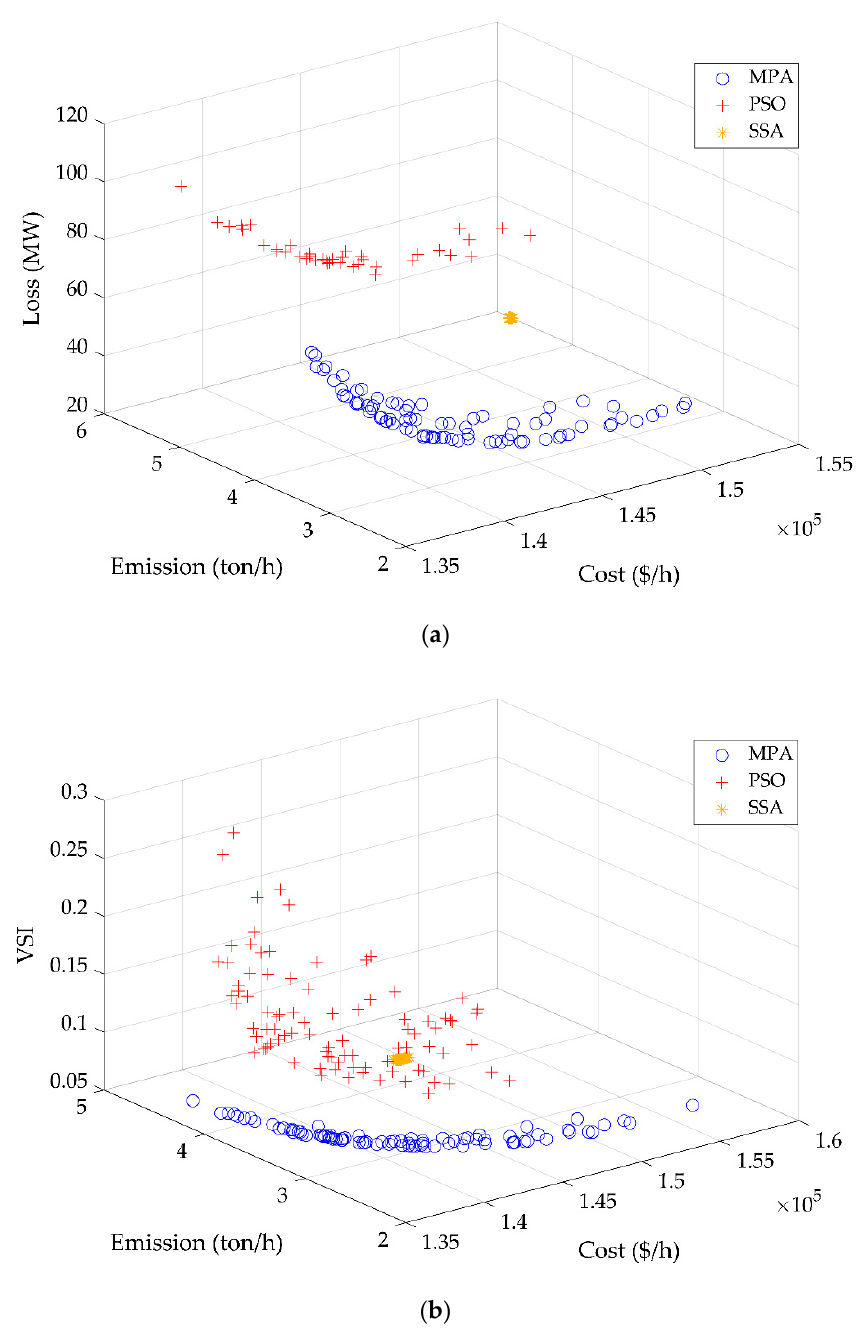
Figure 7. Three-dimensional Pareto fronts for: ( a ) case 17; ( b ) case 18.